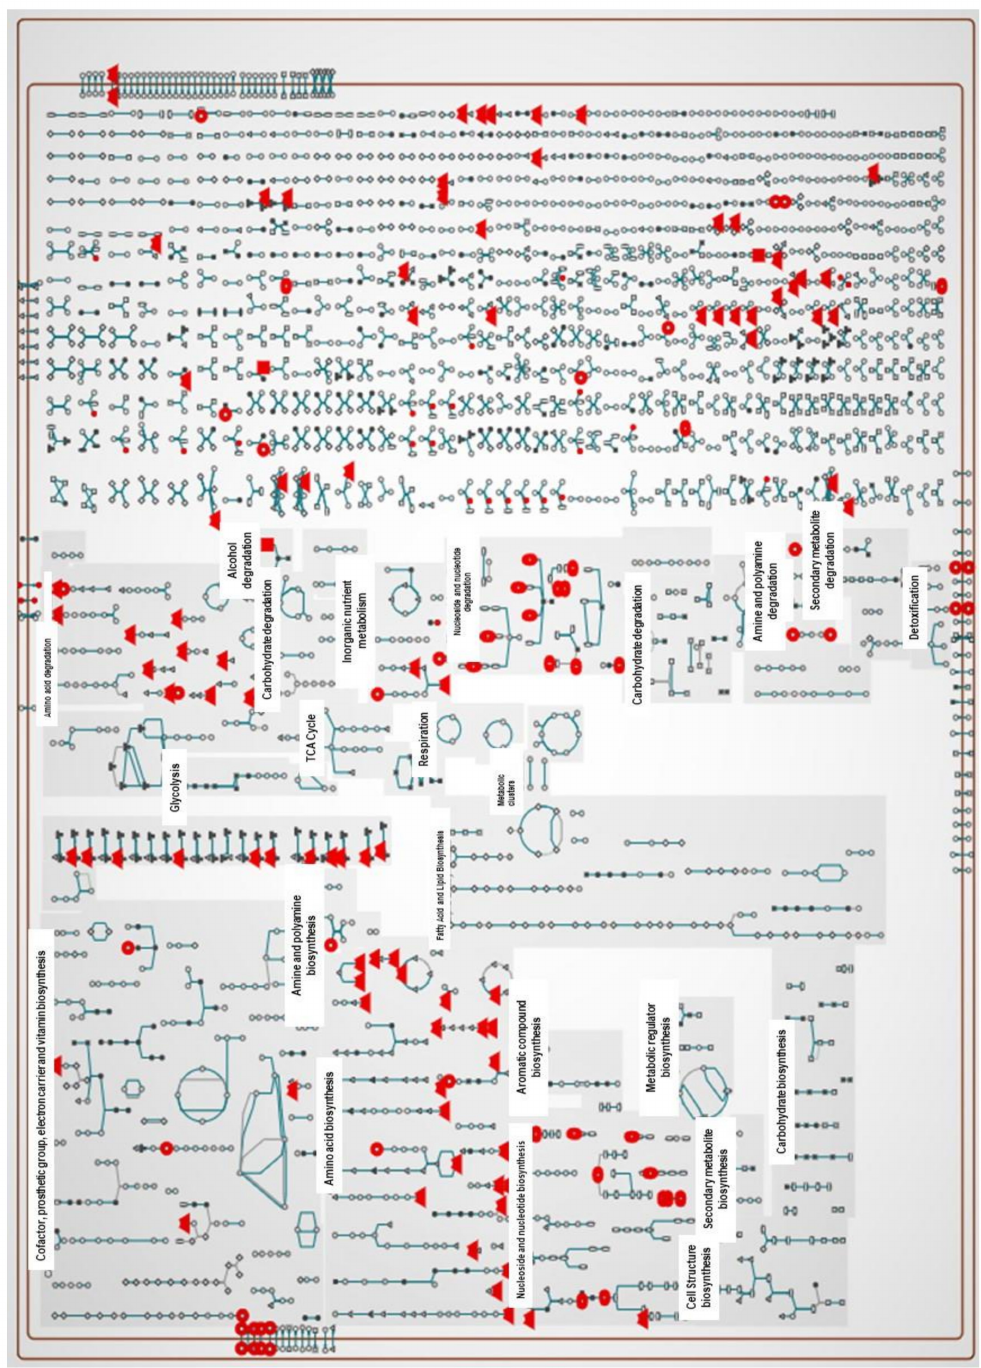
Figure 2. Metabolic pathways of X. perforans showing pathways of interaction of some of the annotated significant metabolites in the positive ion phase when the metabolites are superimposed on the cellular metabolic map of strain Xp91- 118. a. Out of the input of the identified significant 81 metabolites in the positive phase, only 34 metabolites from our dataset were annotated on the cellular metabolic map of Xp91-118 on BioCyc. These metabolites include anthranilate, cytidine, ethanolamine, guanosine, UMP, putrescine, uracil, agmatine, glycero-3-phosphocholine, L-glutamine, L-proline, uridine, urocanate, adenosine, L-serine, 4-aminobutanoate phosphate, 5-aminolevulinate, L-cysteine, L-asparagine, nicotinate, L-lysine, L-isoleucine, glycine, L-cystathionine, taurine, L-methionine, pyridoxine, L-kynurenine, carbamoylputrescine, sulfate 2 (cid:48) -deoxycytidine, biotin, and orotate (pointing up triangles = Amino acids, Square = Carbohydrates, Vertical ellipse = Purines, Horizontal ellipse = Pyrimidines, Circle = Other metabolites. Analysis was carried out using the BioCyc